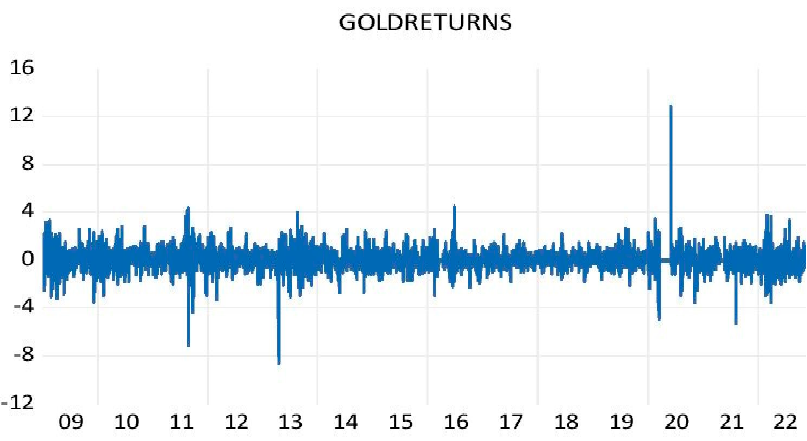
Figure 3. Gold Returns.